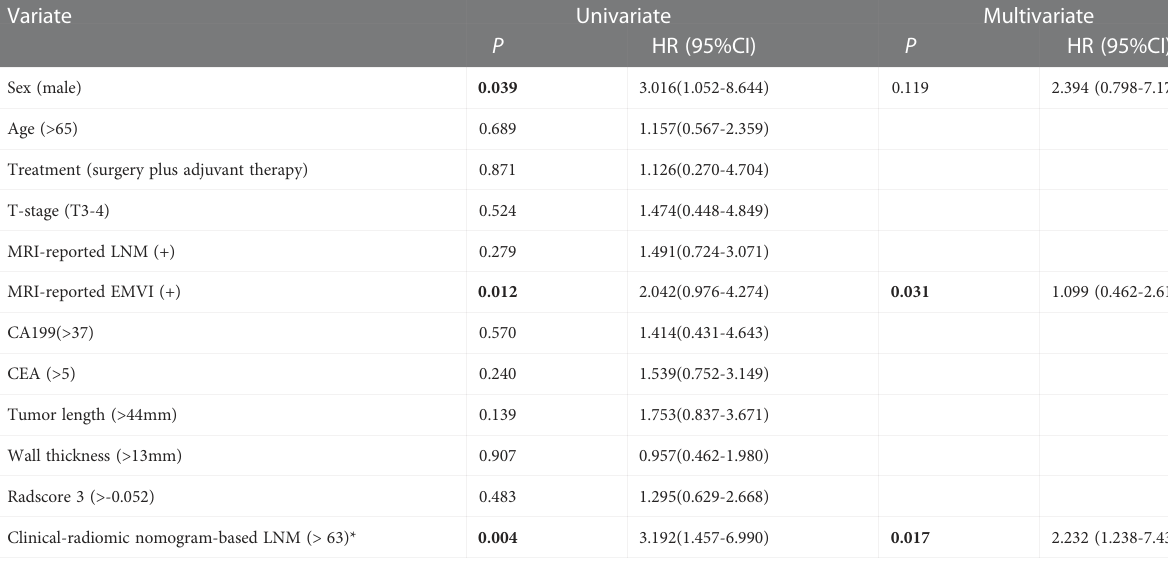
TABLE 4 Univariate and multivariate Cox analysis of 3-year recurrence-free survival based on training cohort. Variate Univariate